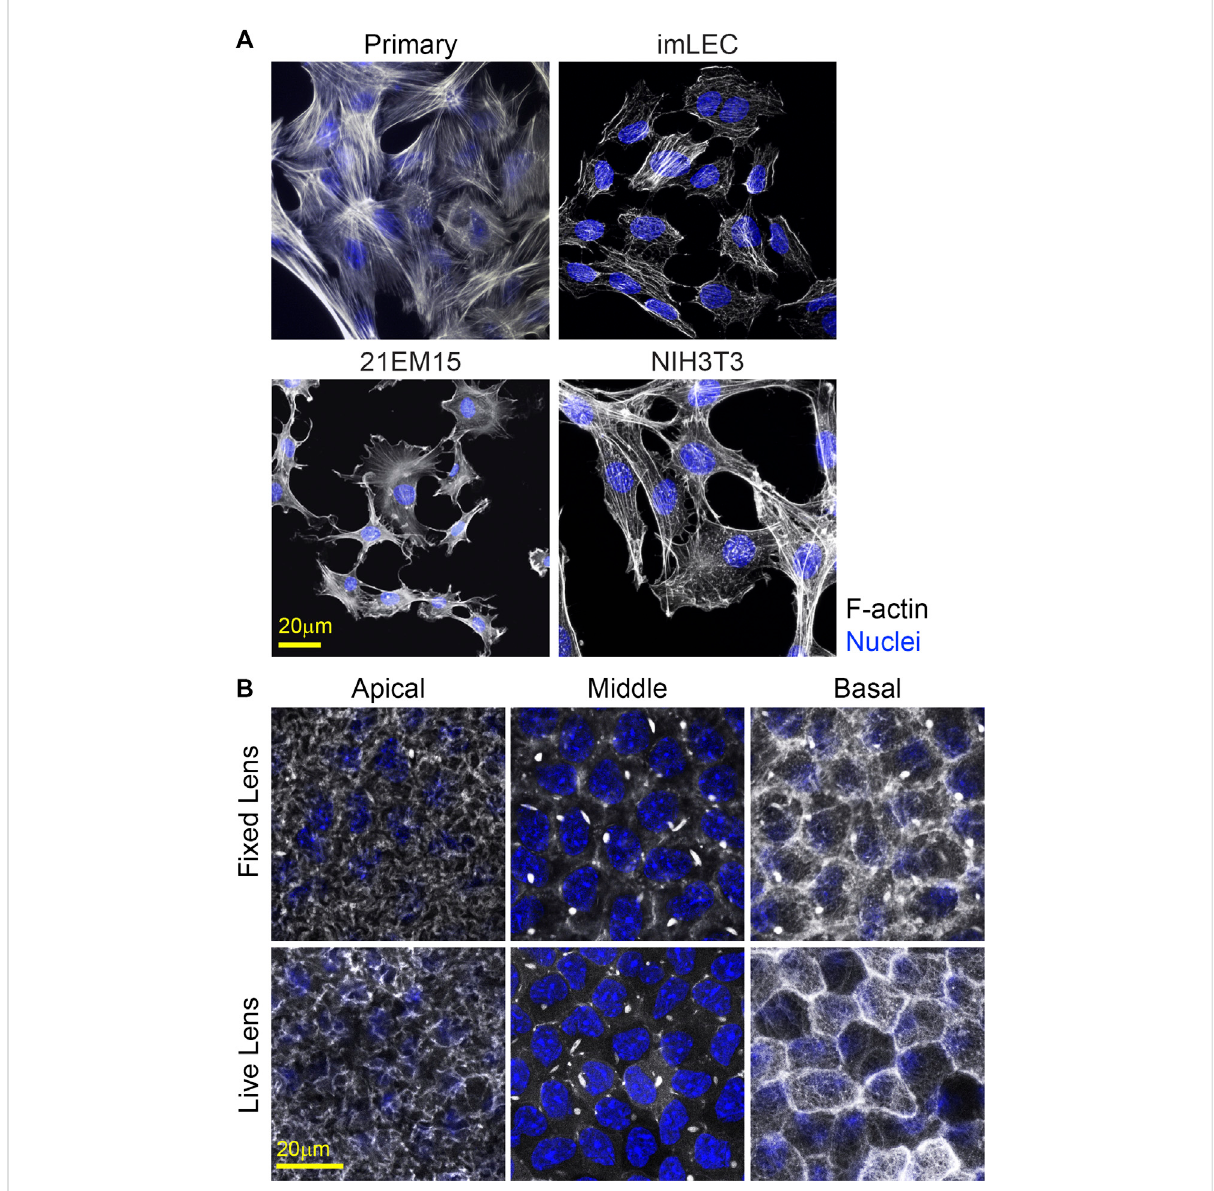
FIGURE 7 F-actinstainingforculturedcellsandinwholemountimagingofF-actinin fi xedandun fi xedlenses. (A) CellswerestainedforF-actin(lightgray) and nuclei (blue). Primary lens epithelial cells cultured after 7 days of initial seeding on glass dishes contain stress fi bers similar to imLECS, 21EM15, and NIH3T3 cells in culture. (B) C57BL/6J wild-type fi xed mouse lenses or LifeAct-GFP transgenic un fi xed mouse lenses imaged for F-actin (light gray) and nuclei (blue). Fixed lenses (wild-type) were stained for F-actin using phalloidin, while un fi xed lenses expressed LifeAct-GFP, allowing for visualization of F-actin directly. The epithelial cells nuclei in both fi xed and un fi xed lenses were stained with Hoechst. Images shown are of single optical slices. Both fi xed and un fi xed lens anterior epithelial cells had similar basal reticular F-actin organization with limited stress fi bers. At the middle region in the lateral sides of these cuboidal cells, F-actin is at cell – cell junctions and within the bright structures called sequestered actin bundles (SABs).The basal region of fi xedlens epithelial cells differed from that inun fi xedlenses.In theun fi xedlens, thebasal region oflens epithelial cells had polygonal actin arrays, while, in the fi xed lens, the polygonal arrays appear disrupted on the basal surface of these epithelial cells. Furthermore, SABs were present in the basal region of fi xed lens epithelial cells. Scale bars, 20 μ